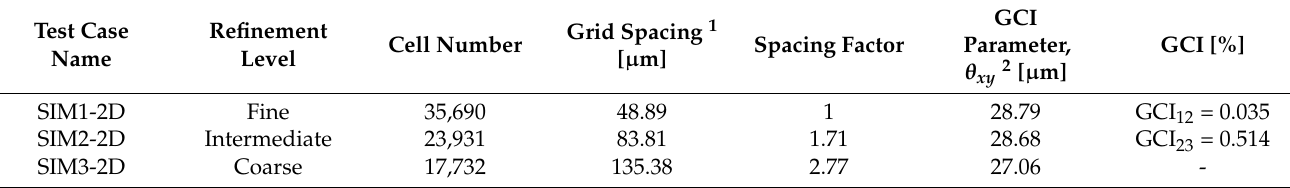
Table 3. 2D grid independence study in the symmetry plane ( 0,x,y )